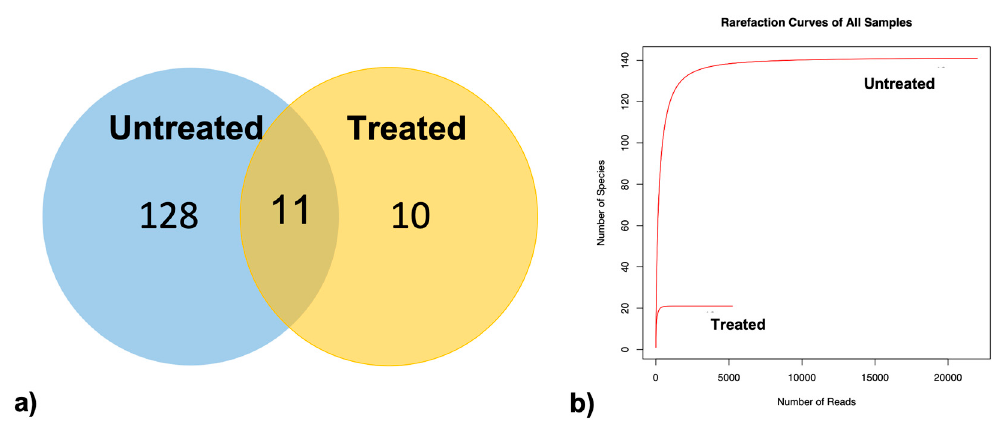
Figure 6. Panel ( a ) represents the Venn diagram, which illustrates overlap of bacterial amplicon sequence variants (ASVs) between treated and untreated samples. Numbers inside circles indicate the number of unique ASVs in one of the subsets. The number in the overlapping region indicates the number of shared ASVs between samples. Panel ( b ) display the rarefaction curves of the bacterial communities based on 16S rRNA gene sequences.